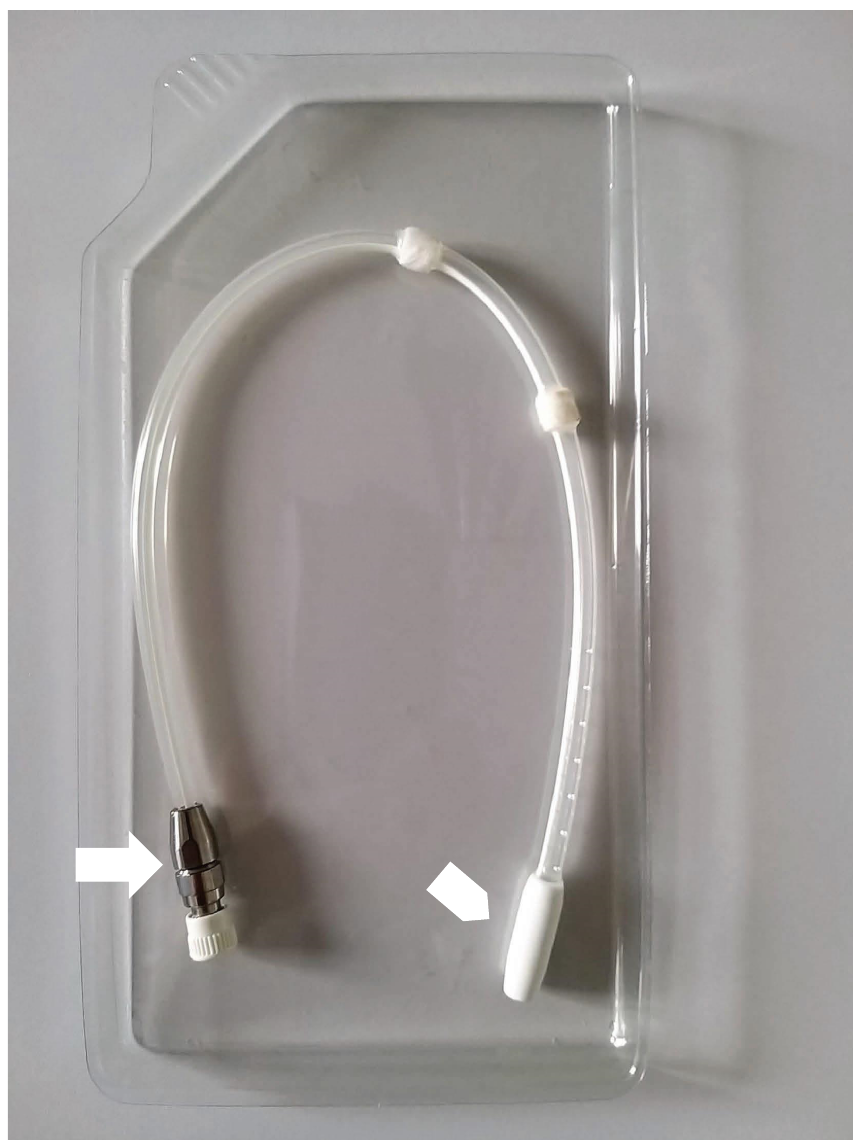
Figure 1: Peritoneal dialysis catheter into the plastic box containing saline solution ( ∗ ) with its tip tungsten ballast (arrowhead) and, on the other extremity, the titanium connector